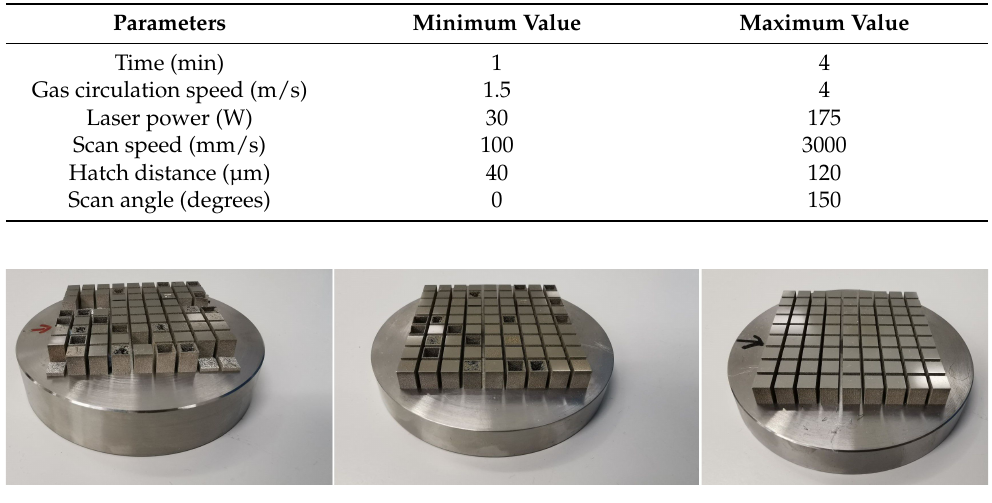
Figure 1. Sample of 243 specimens printed under different processing